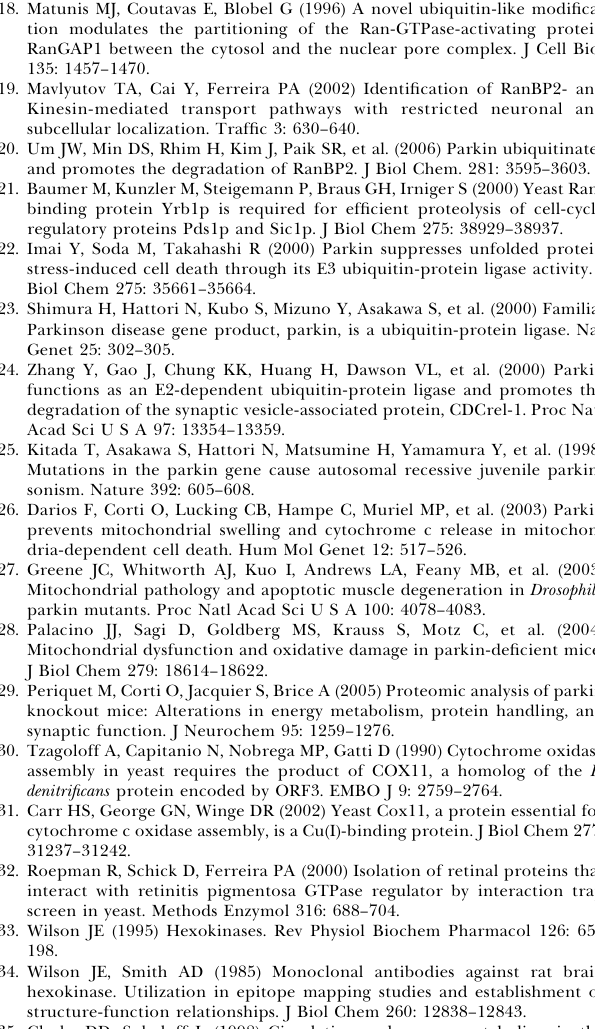
Figure S3. Metabolic Phenotype of RanBP2 þ / (cid:1) Mice in a Mixed Background and High-Fat Diet There was no difference in the glucose tolerance test between RanBP2 þ / þ and RanBP2 þ / (cid:1) mice on a mixed 129Ola/C57Bl6 genetic background (C). Found at DOI: 10.1371/journal.pgen.0020177.sg003 (38 KB